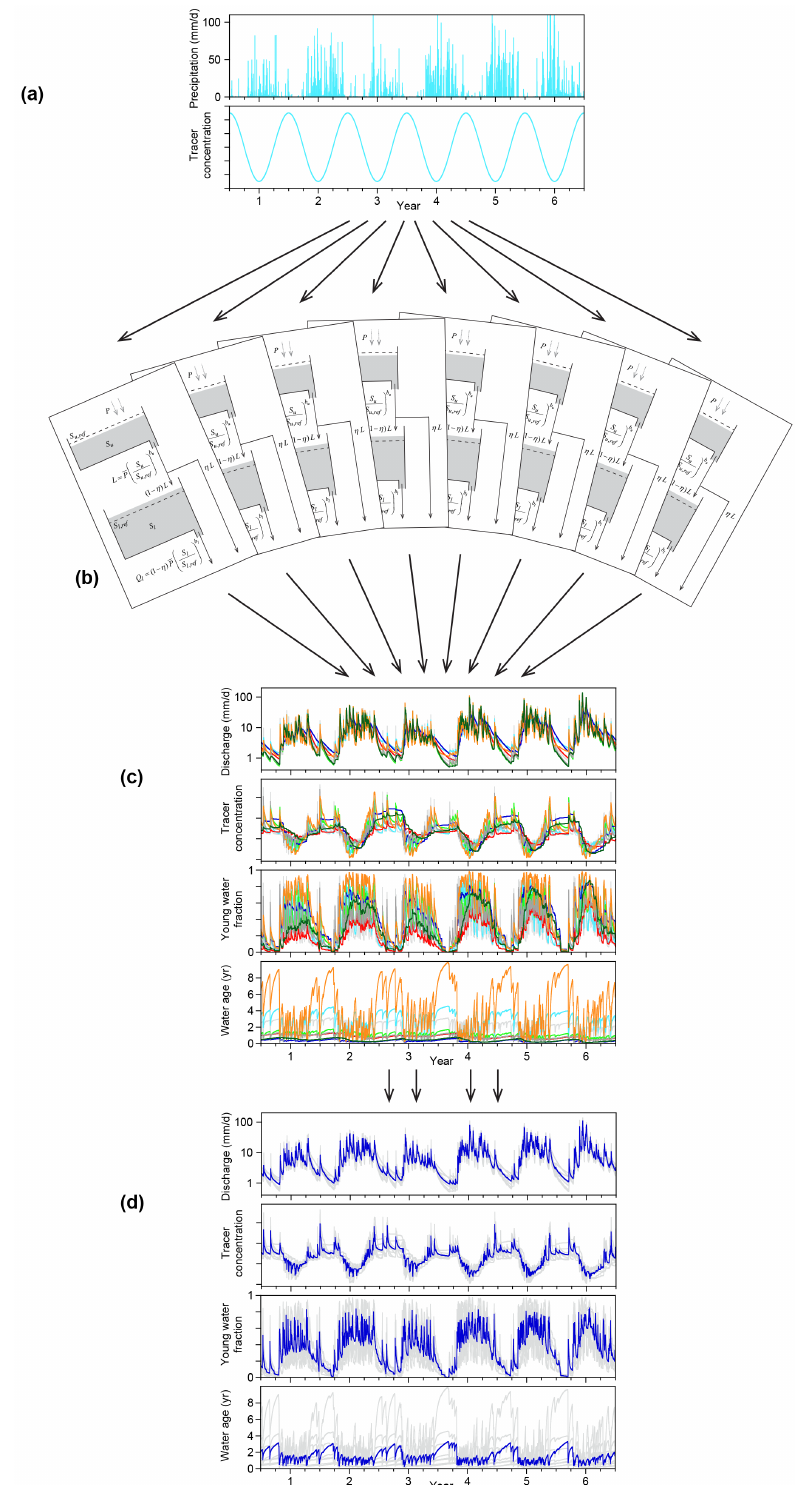
Figure 11. Scheme for simulating spatially heterogeneous catchments with nonstationary tributary subcatchments. A single precipitation time series (a) is used to drive eight copies of the model representing eight tributary streams (b) , each with a different set of random parameter values. Streamflows, tracer concentrations, young water fractions, and water ages from these eight nonstationary tributaries ( c , with each color representing a separate tributary stream) are mass-averaged to determine the time series that would be observed in the merged streamflow ( d , with blue lines showing the merged streamflow and gray lines showing the